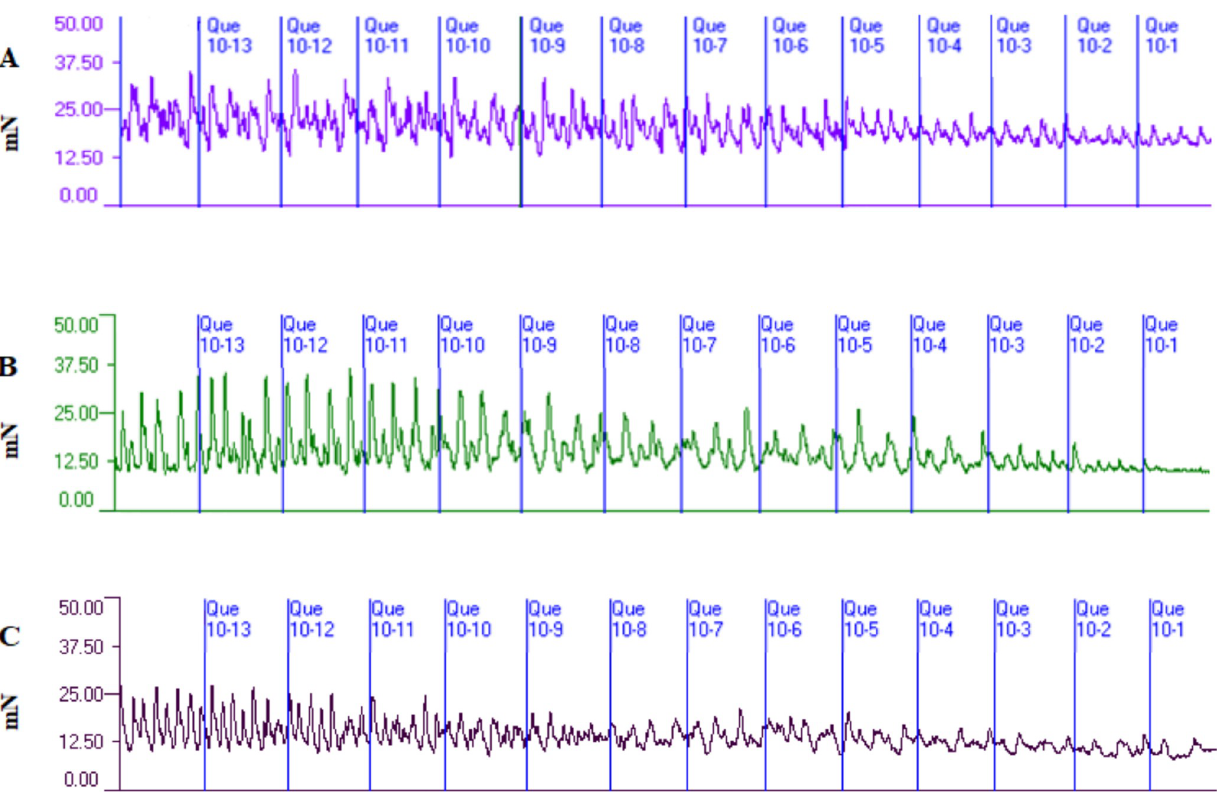
Fig 1. Diagrams of contractile activity. Diagrams showing the contractile activity of the porcine myometrial strips collected from sexually immature gilts (A), on days 12–14 of the oestrous cycle (B) and on days 12–16 (C) before (15 min) and after administration of concentration (Que; 10 − 13 –10 − 1 M).